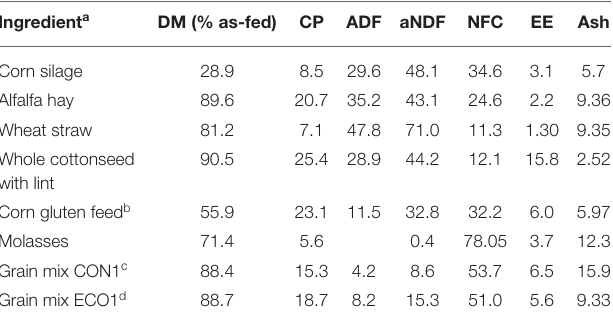
TABLE 2 | Chemical composition of feeds used in Experiment 1 (% of DM, otherwise stated). Ingredient a DM (% as-fed) CP ADF aNDF NFC EE Ash Corn silage